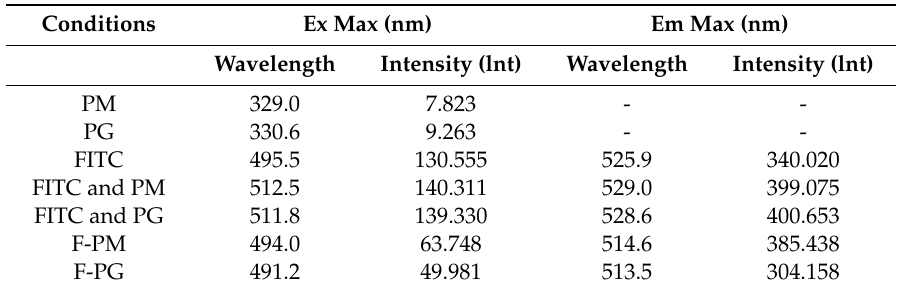
Table 3. Full wavelength scan value of the sample.